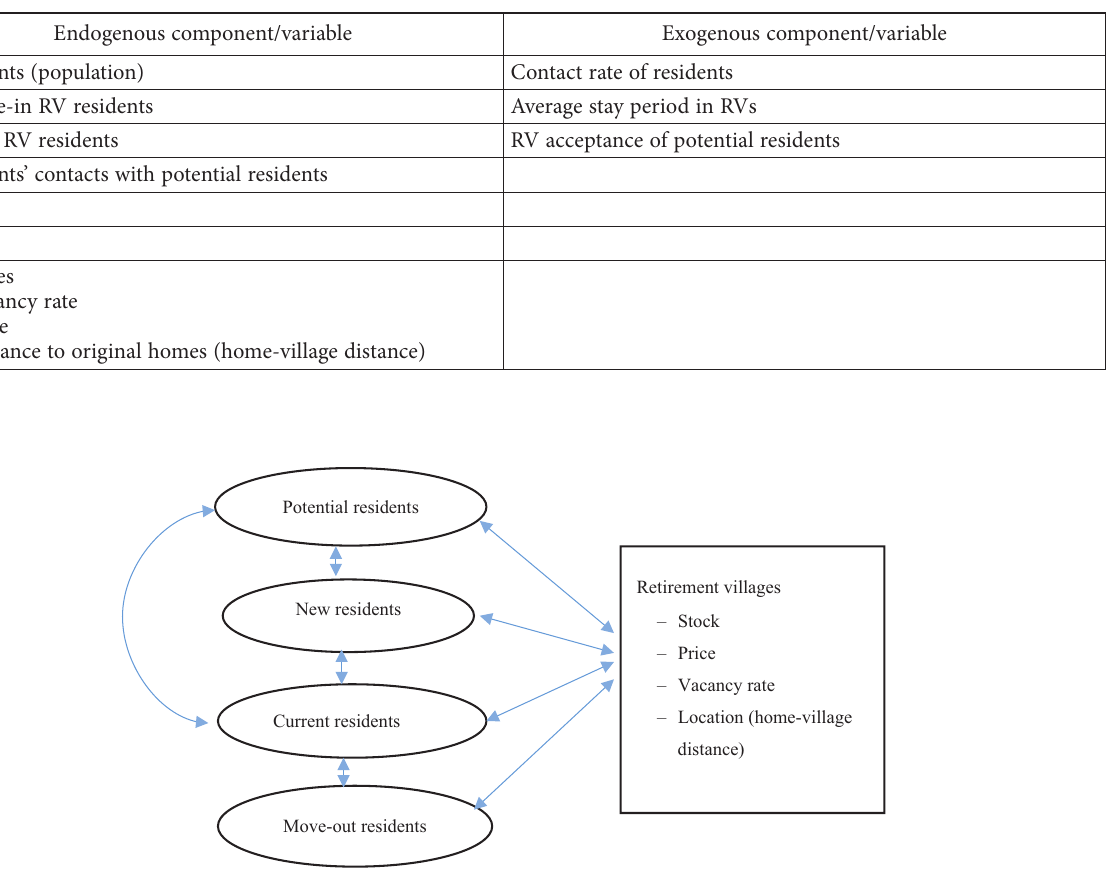
Figure 2. Subsystem diagram of the RV